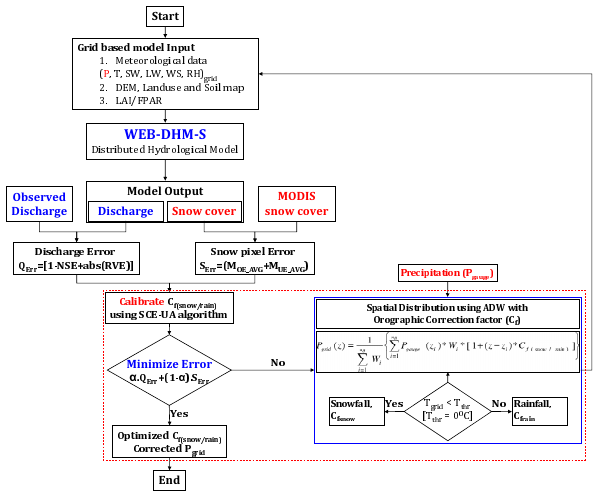
Fig. 3. Overview of methodological framework.